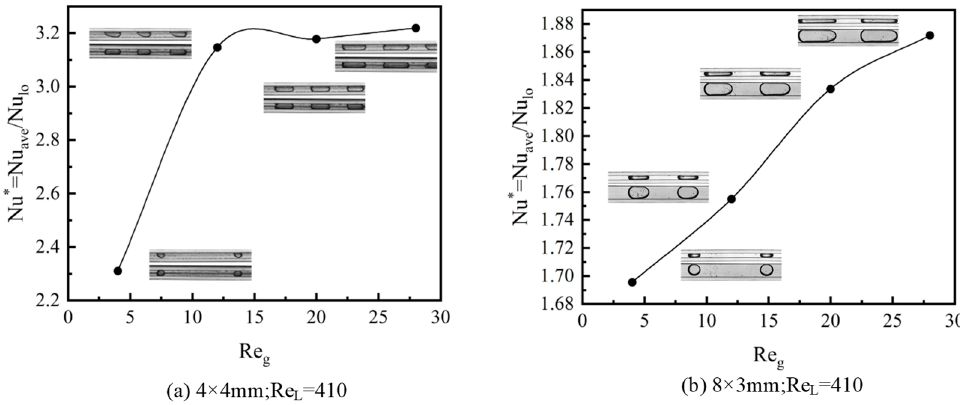
Figure 10. Gas Reynolds number’s impact on improved heat transfer.